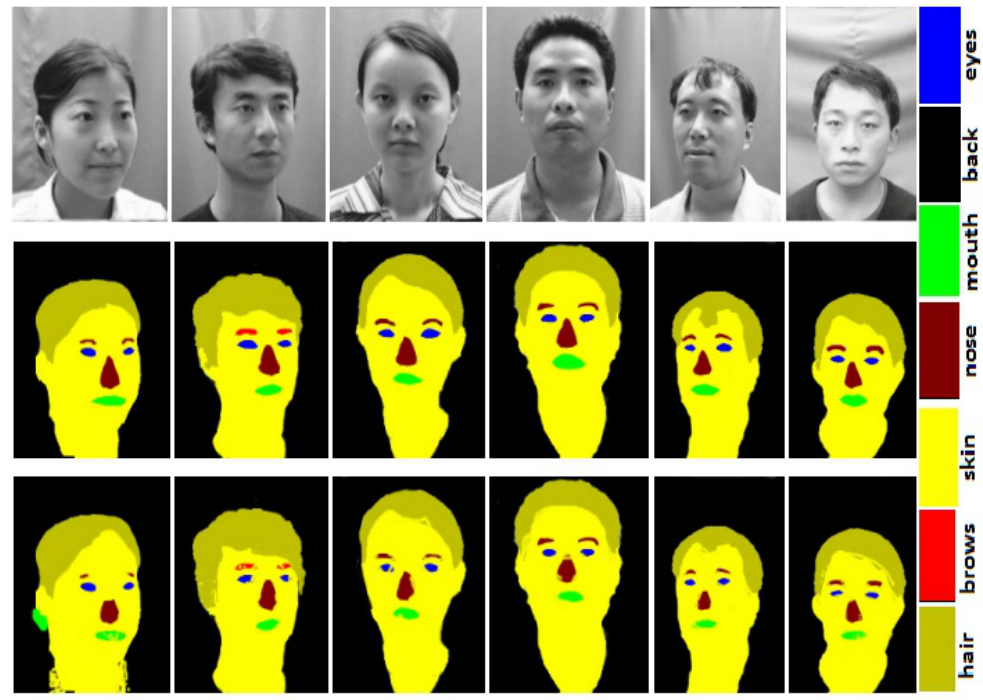
Figure 3. Face images from CAS-PEAL [32] dataset in row 1, ground truth in row 2, and face segmentation results in row